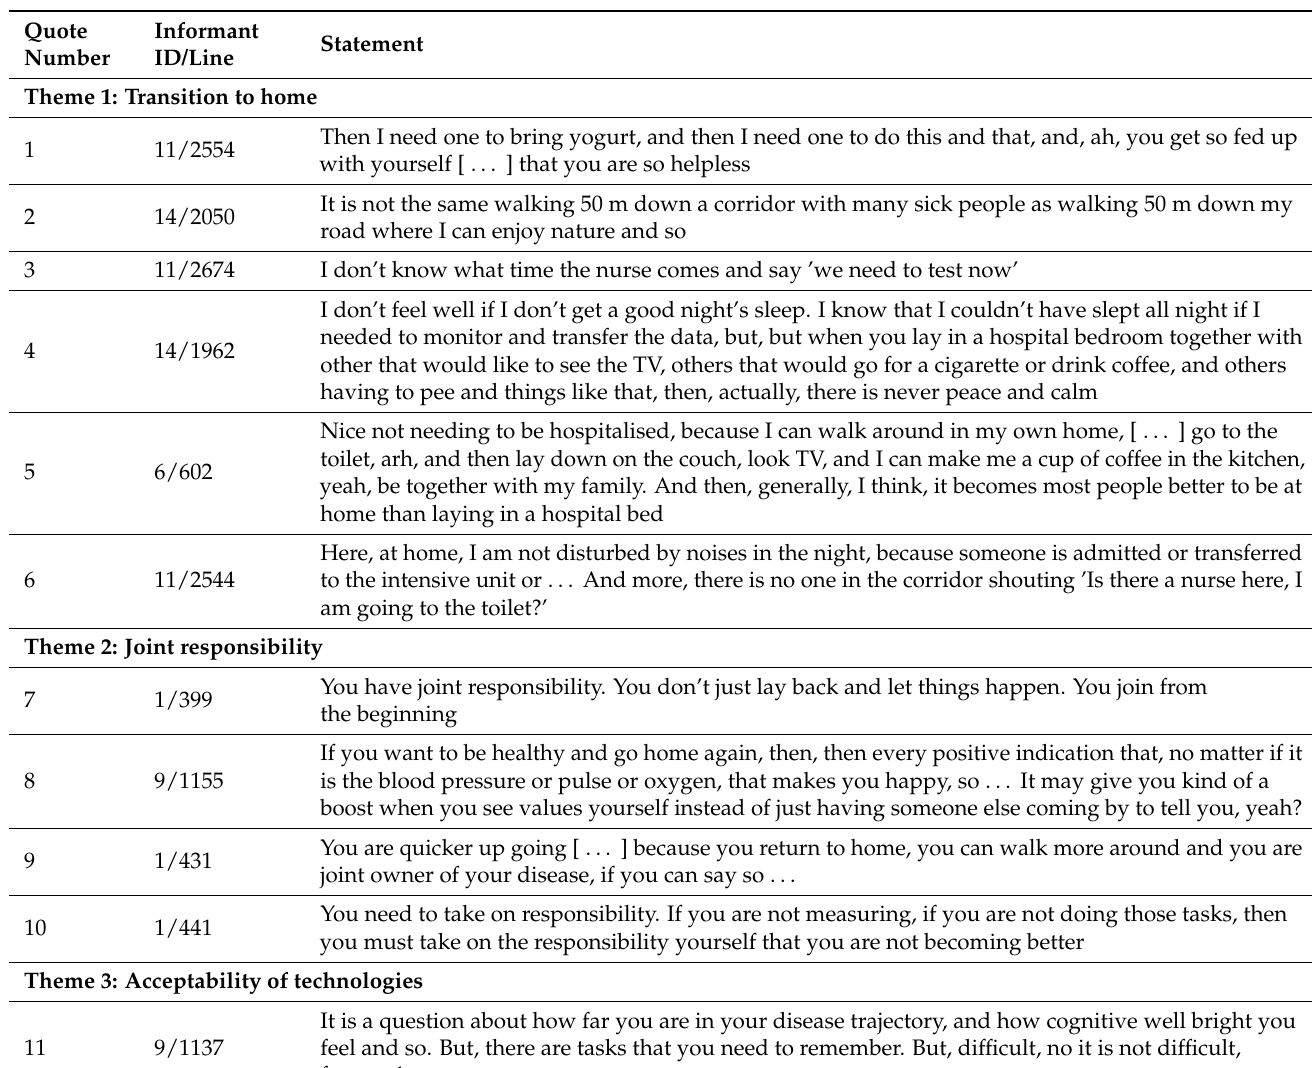
Table 2. Quotes from the patients’